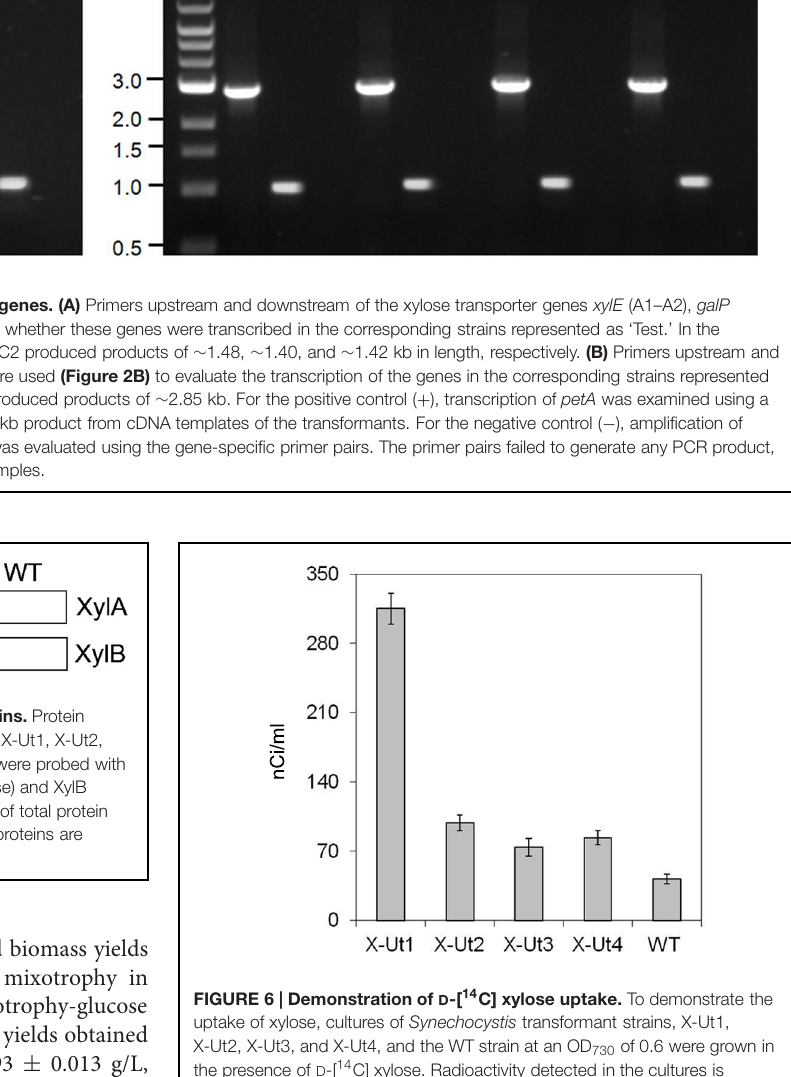
namely X-Ut1, X-Ut2, X-Ut3, and X-Ut4, utilize xylose.